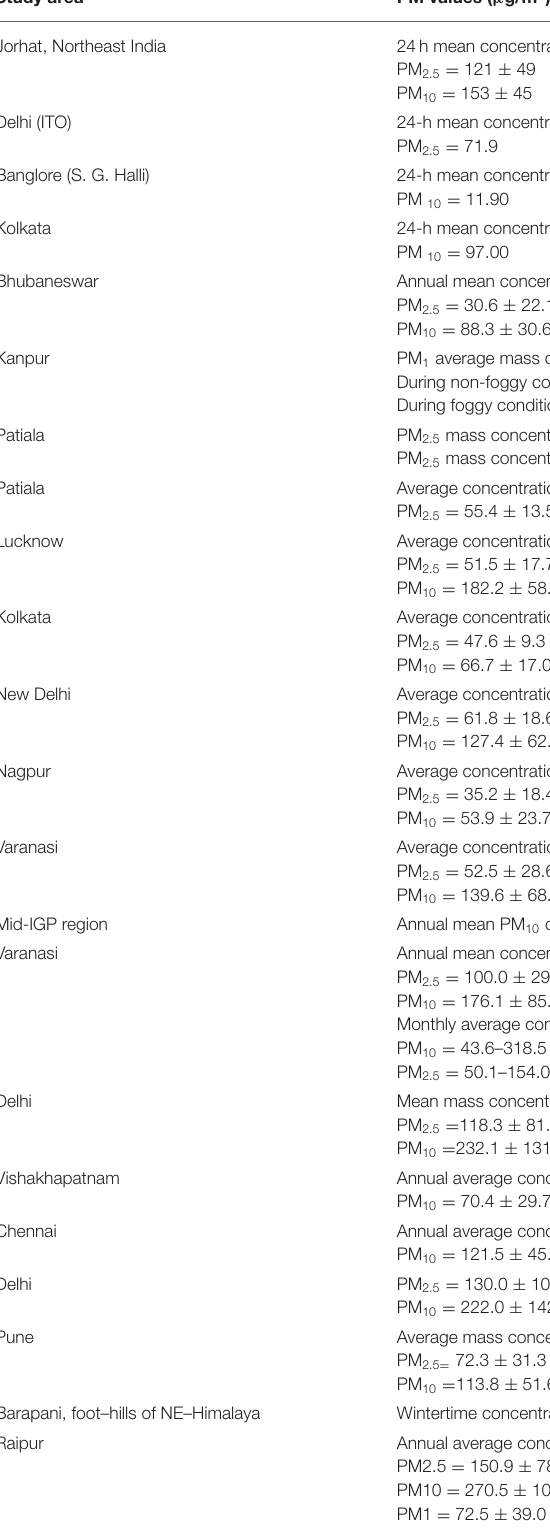
TABLE 1 | PM values for some Indian cities during different years. Study